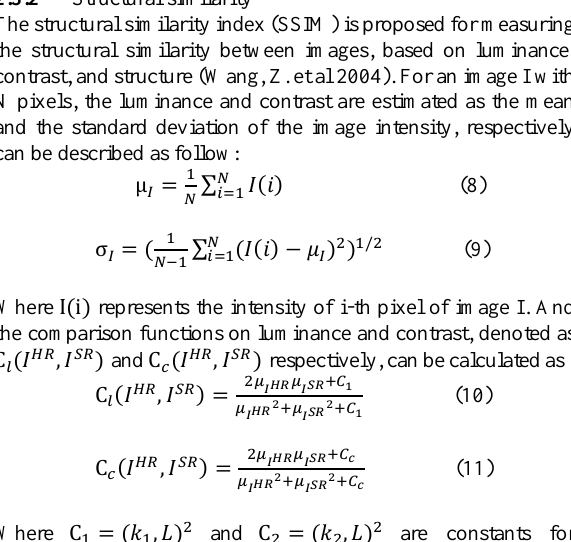
Figure 1 (a). Architecture of Generator Network